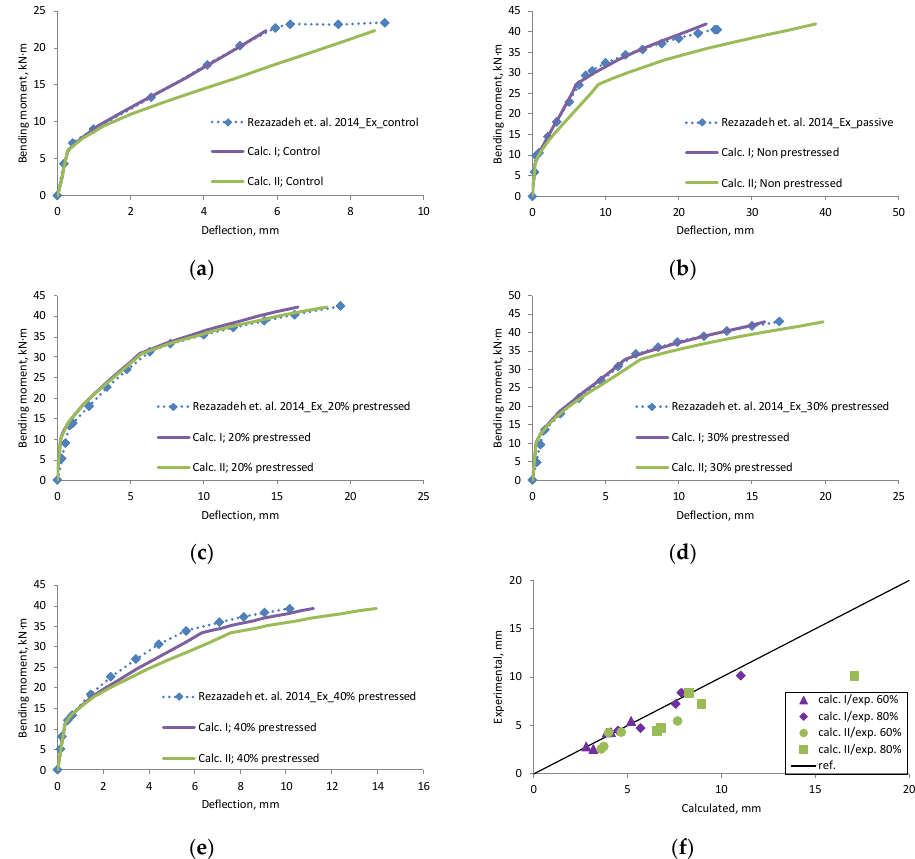
Figure A16. Rezazadeh et al., 2014 [39] research beams deflection compared with calculated, ( a ) beam Control; ( b ) beam Non prestressed; ( c ) beam 20% prestressed; ( d ) beam 30% prestressed; ( e ) beam 40% prestressed; ( f ) scatter of the results at 60% and 80% of the ultimate load.